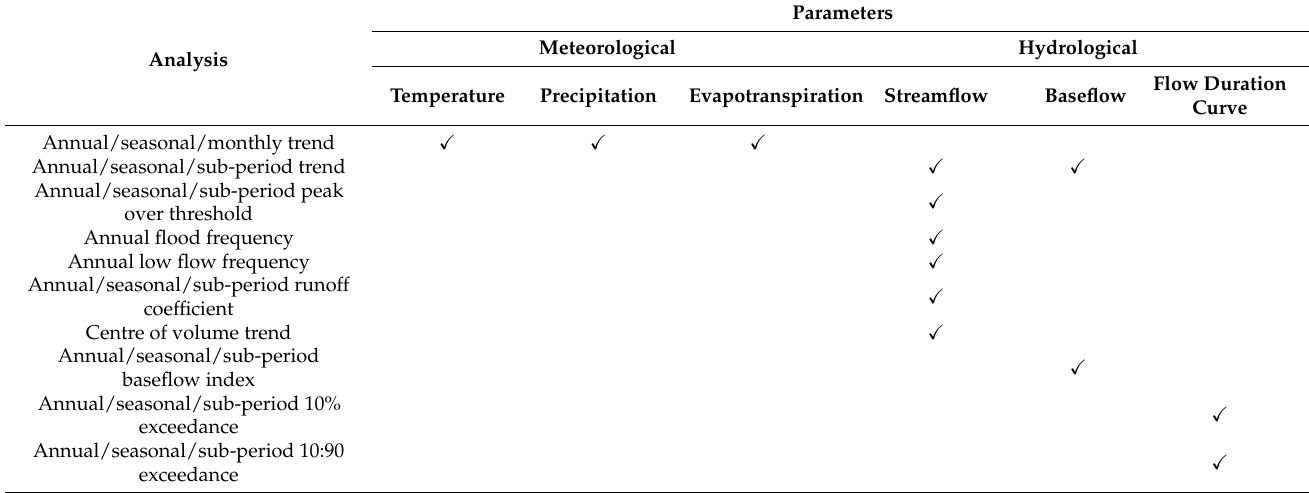
Table 2. Climate and streamflow matrix used for the